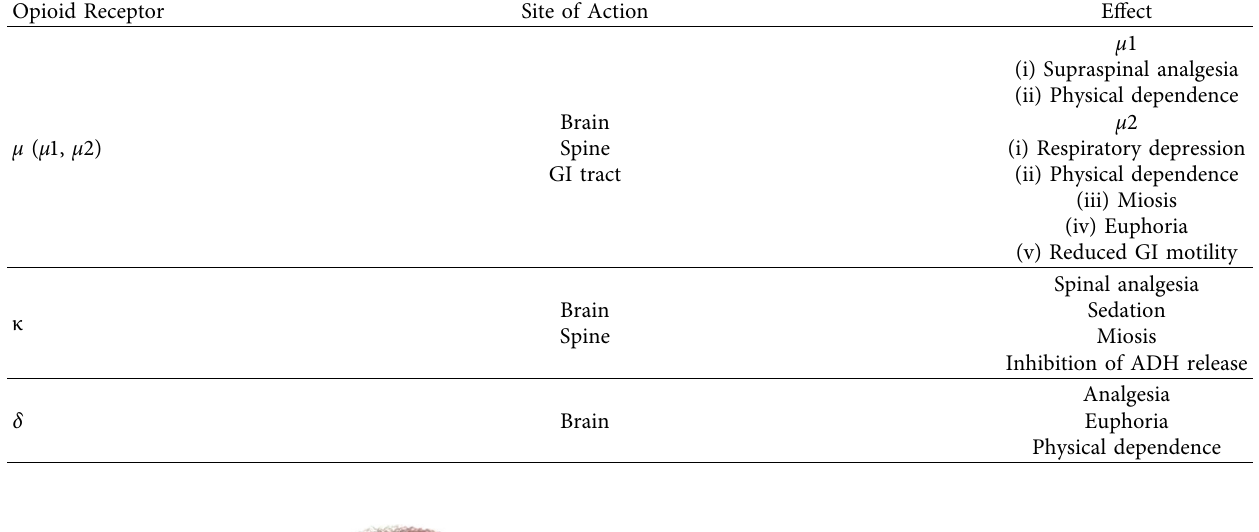
Table 1: Opioid receptor characteristics.